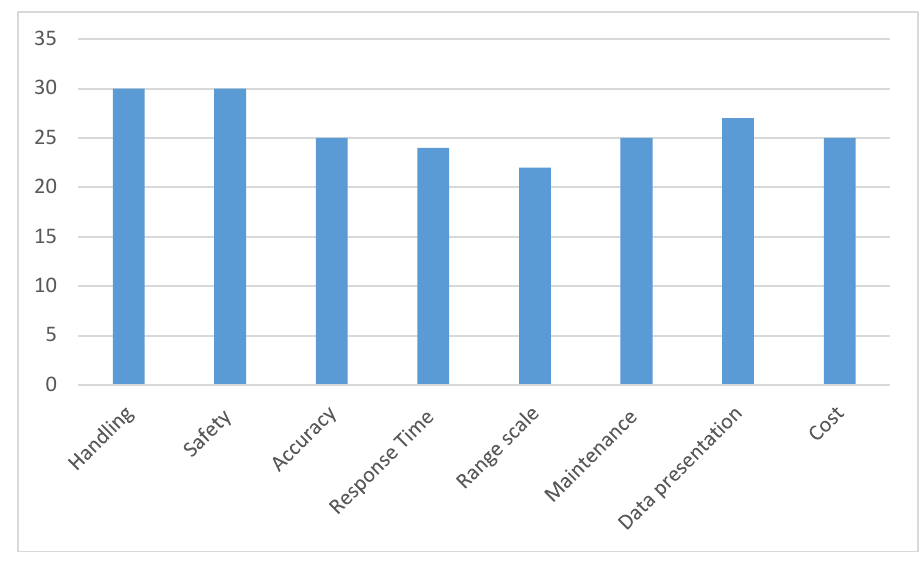
Figure 5. Teachers’ perspective on sensor attributes where the Y-axis represents number of teachers participated in the focus group and one-on-interviews ( N = 30)